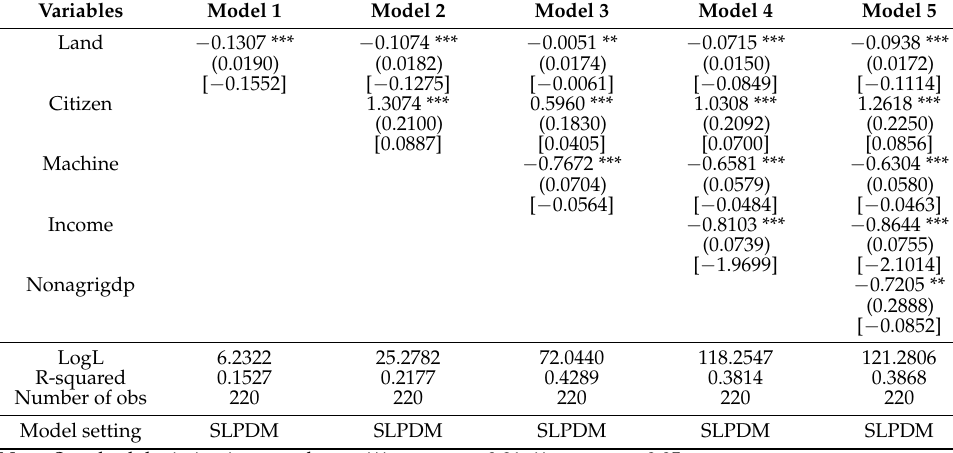
Table 5. Empirical results of factors affecting corn production